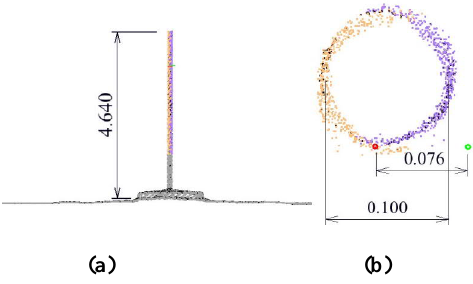
Figure 16 . An example of an erroneous result for identified tie points on a pole (a) cross-section; (b) top view.